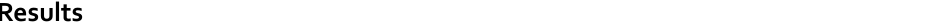
Figure 1. A TIM4-affinity ELISA screen in U87MG cells identified eight activators and one inhibitor of extracellular vesicles (EVs). ( a ) The principle of TIM4-ELISA. EVs are captured by immobilized TIM4-Fc proteins via calcium-dependent binding to phosphatidylserine on the surface of EVs. Then, the captured EVs are detected with a primary antibody against an EV surface marker, such as, anti-CD9, anti-CD63, or anti-CD81, and an HRP-conjugated secondary antibody. ( b ) K562 cells were stimulated for 24 h with 0.1, 1, or 10 μM monensin. EVs contained in the cultured supernatants were detected using TIM4-CD63 ELISA (left) and nanoparticle tracking analysis (NTA; right). ( c ) In the first round of screening, U87MG cells were treated with a 1,567-compound library at 0.1, 1, or 10 μM for 24 h. EVs contained in the cultured supernatants were detected using TIM4-CD63 ELISA. A typical result is shown here. The two dashed lines represent the threshold values for activators and inhibitors, at 0.67 and 1.5, respectively. ( d – m ) U87MG cells were treated with 10 μM AA2, 7 μM amlodipine, 2 μM osimertinib, 1 μM cucurbitacin B, 2 μM doramectin, 10 μM gossypol, 15 μM HA14-1, 20 μM miltefosine, or 1 μM obatoclax for 24 h. Cytotoxicity and cell growth were determined using lactate dehydrogenase (LDH) ( d , i ) and WST-8 ( e , j ) assays. Cells treated with lysis buffer were used as a positive control (PC) in the LDH assay. Secreted EVs were detected using TIM4-CD9 or TIM4-CD63 ELISA ( f , k ), Secreted EVs were recovered using ultracentrifugation and subjected to western blot with an anti-CD9 or anti-CD63 antibody ( g , l ), and NTA ( h , m ). Full-length blots can be found in the supplementary information. * p < 0.05, ** p < 0.01, versus DMSO, Student’s t